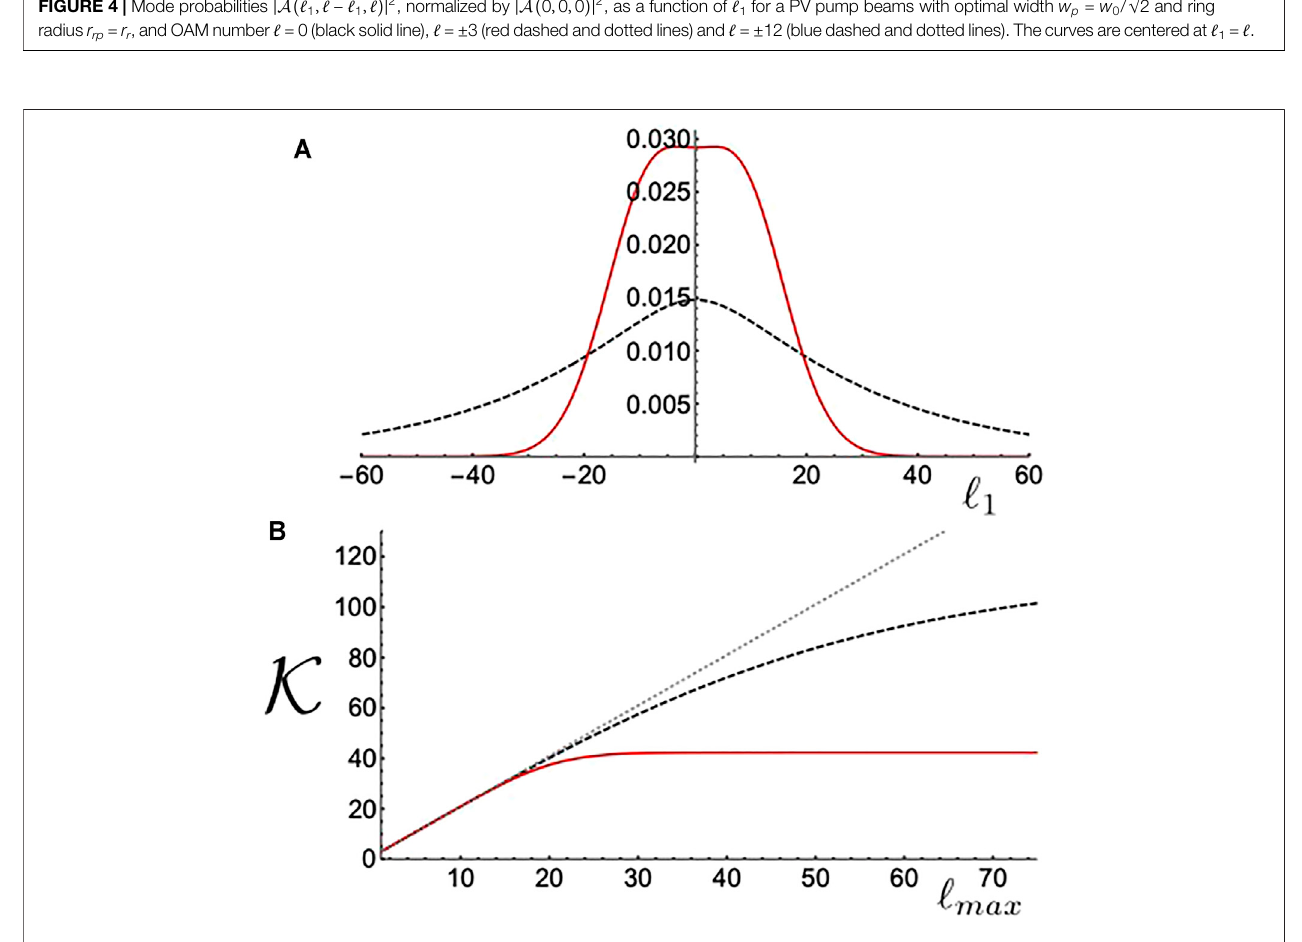
Frontiers in Physics |